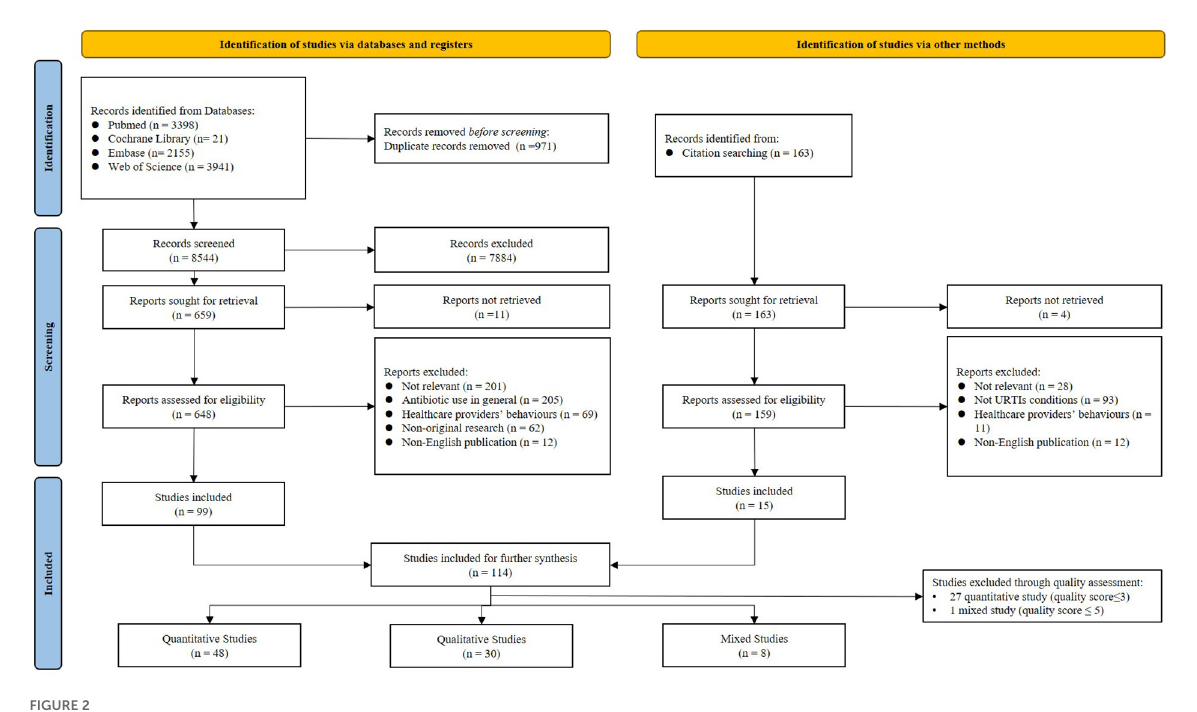
FIGURE2 PRISMA flow